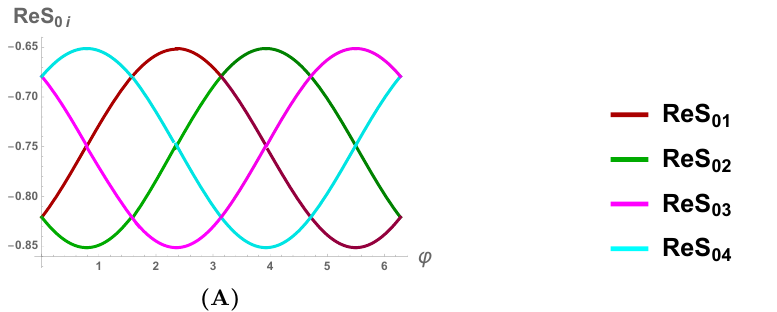
Figure 3 . ( A ). Plots for real parts of the actions on the stationary point functions, ReS 0 ;i ( a; ’ ) for J = 1, a = 0 : 1 and 0 < ’ < 2 (cid:25) , i = 1 ; 2 ; 3 ; 4 corresponding to the (cid:12)rst, second, third and fourth stationary points are presented by darker red, green, magenta and cyan color,